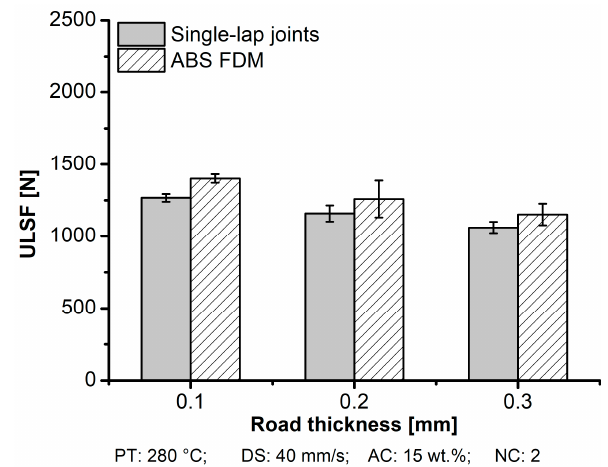
Figure 13. Influence of the road thickness on ULSF for aluminum 2024-T3/ABS hybrid joints (single-lap joints) and ABS BM FDM; (condition four, RT: 0.1 mm; condition three, RT: 0.2 mm; condition five, RT: 0.3 mm; the following parameters PT: 280 °C, DS: 40 mm/s, AC: 15 wt.%, and NC: 2 were fixed for the conditions investigated).